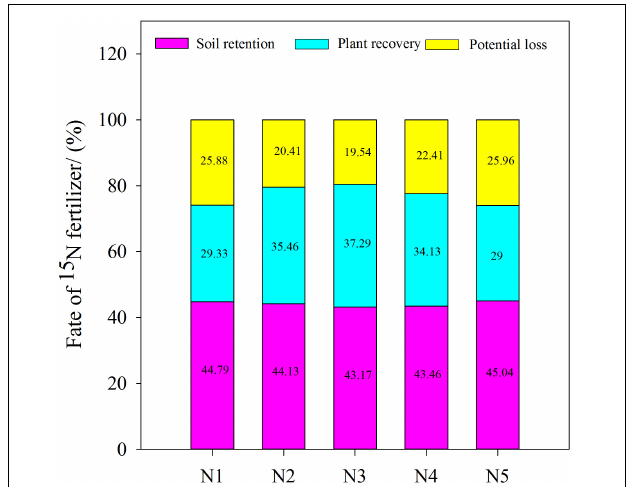
FIGURE 6 | Effect of split nitrogen fertilizer on the fate of 15 N fertilizer in plant-soil system. N1 (basal/dressing, 100/0%), N2 (basal/dressing, 70/30%), N3 (basal/dressing, 50/50%), N4 (basal/dressing, 30/70%), and N5 (basal/dressing,